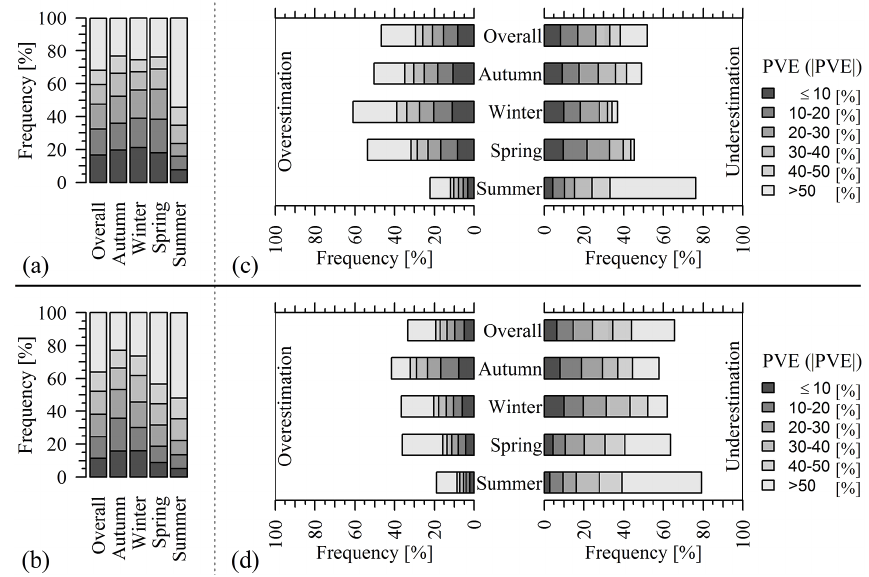
Figure 3. Stacked-column plots of (1) PVE counts of the six absolute PVE classes ( ≤ 10, 10–20, 20–30, 30–40, 40–50 and > 50%) during calibration (a) and validation (b) , and (2) the fraction of times under- and overestimation incidents corresponding to the six PVE classes occurred during calibration (c) and validation (d)